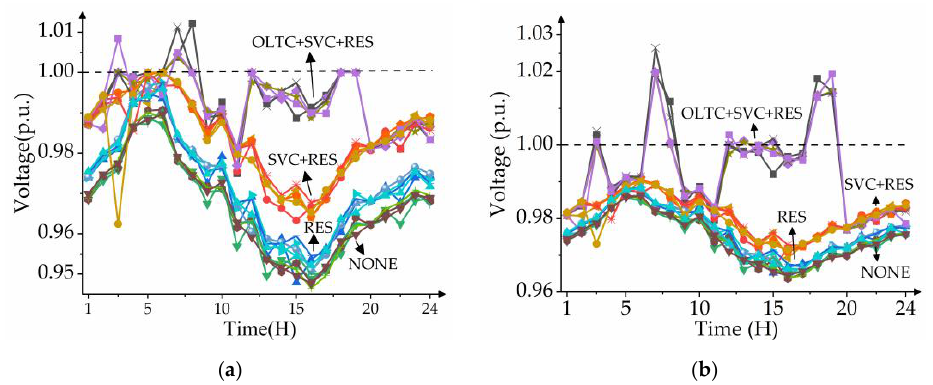
Figure 2. The result of the real-time dispatching in different typical scenes. ( a ) The day-here voltage profile of bus 14. ( b ) The day-here voltage profile of bus 26.